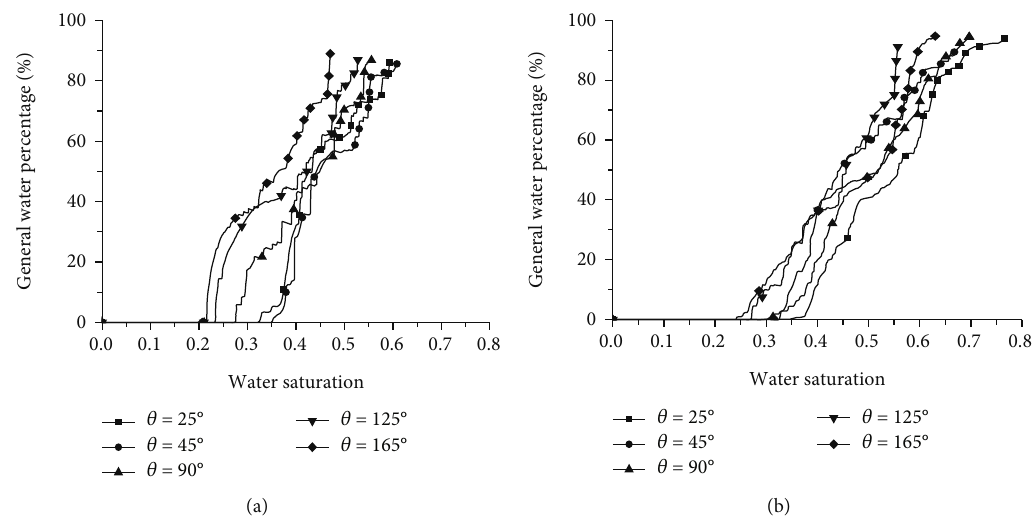
Figure 7: Water fl ooding curve under di ff erent wettability at the same injection velocity: (a) u = 0 : 10m · s − 1 ; (b) u = 0 : 30 m · s − 1 .